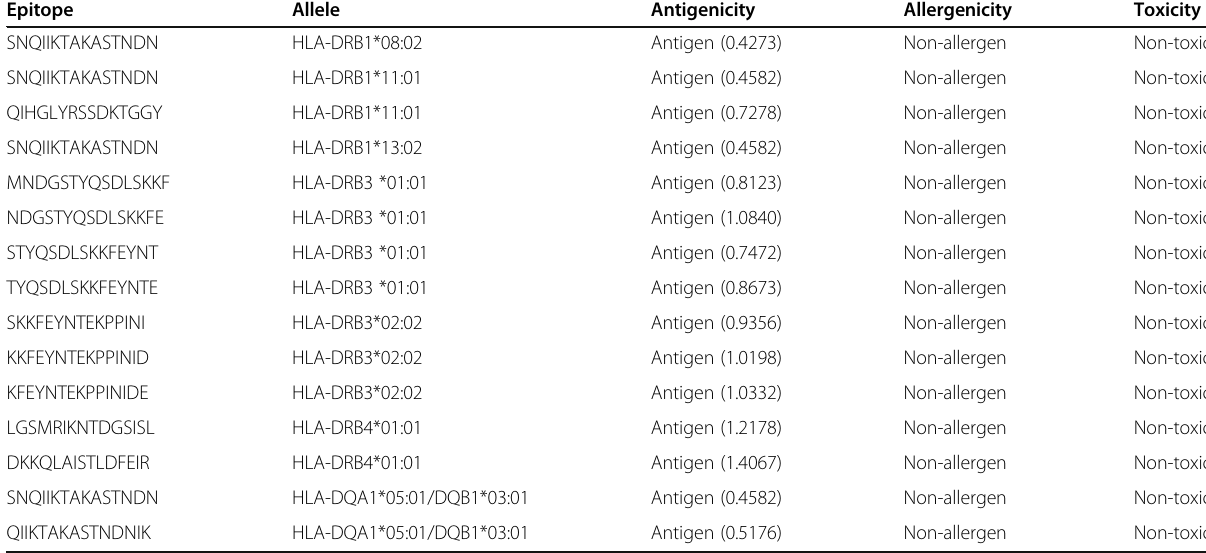
Table 2 Final HLA-II epitopes for vaccine construction